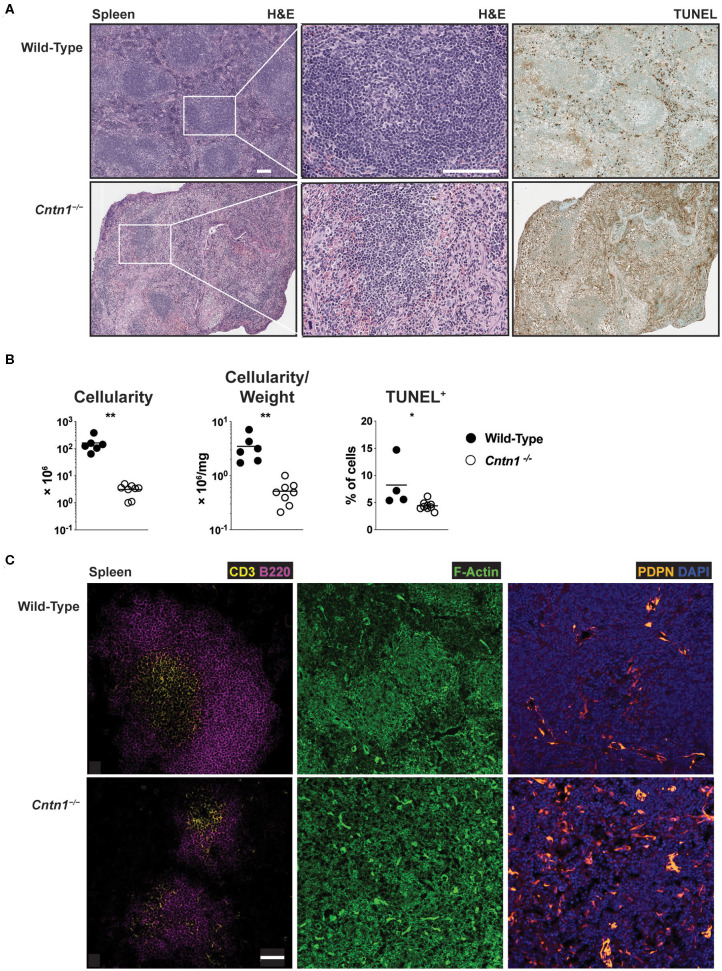
Disorganized architecture of Cntn1-deficient spleens (A). Representative images of spleens from wild-type (left) and Cntn1−/− (right) at 4 × (H&E, upper panels; TUNEL, lower panels) or 10 × (H&E, middle panels). White scale bars represent 100 μm (B). Graphs show spleen cellularity (left), cellularity normalized to organ weight (middle), or TUNEL+ cells (right) from individual wild-type and Cntn1−/− animals. Analysis of aggregated data by Student's t-test (C). Representative immunofluorescence images of spleens from wild-type (top) and Cntn1−/− (bottom) costaining for CD3 (yellow) and B220 (magenta) (left panels, 4 ×), F-actin (phalloidin-green) (middle panels, 4 ×), and PDPN (orange) and DAPI (blue) (right panels, 4 ×). White scale bar represents 50 μm. *p < 0.05; **p < 0.01.